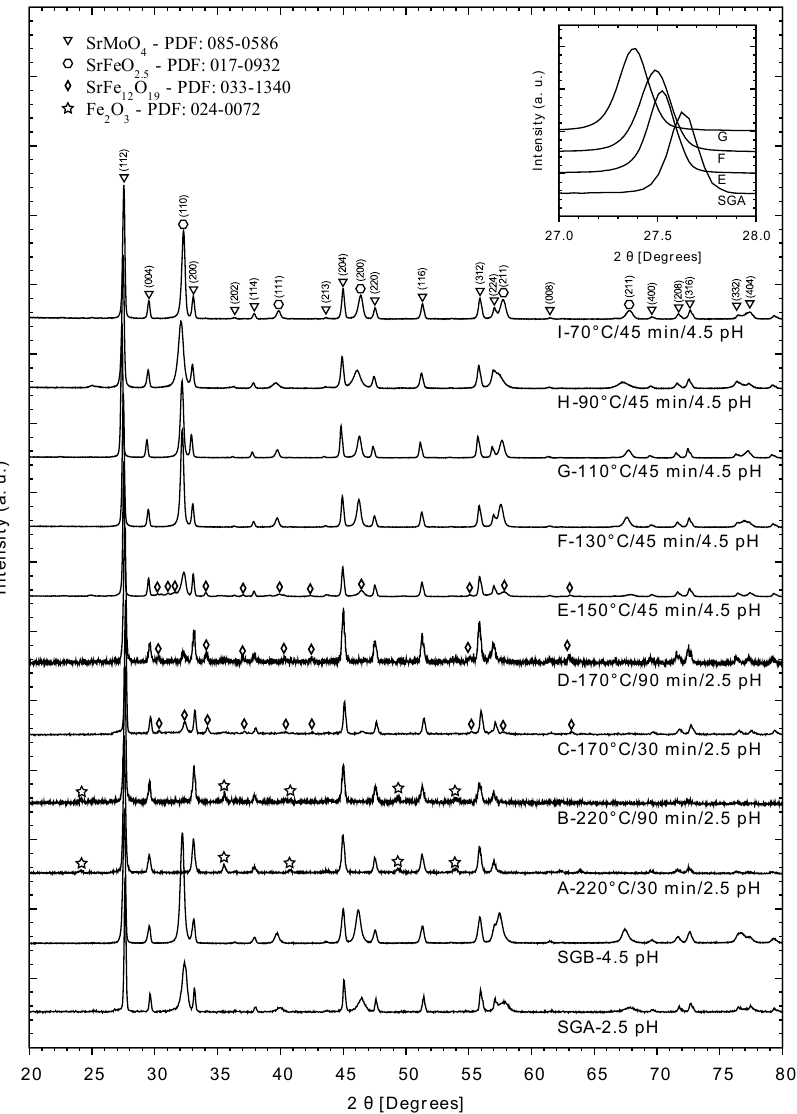
Figure 2. XRD patterns of powders obtained after calcination for reference experiments (SGA and SGB) and those in which microwave radiation was used (A, B, C, D, E, and F). Bragg reflections attributed to the metallic precursors are highlighted (SrMoO 4 (PDF: 085-0586), SrFeO2.5 (PDF: 017-0932), SrFe 12 O 19 (PDF: 033-1340) and Fe 2 O 3 (PDF: 024-0072)).